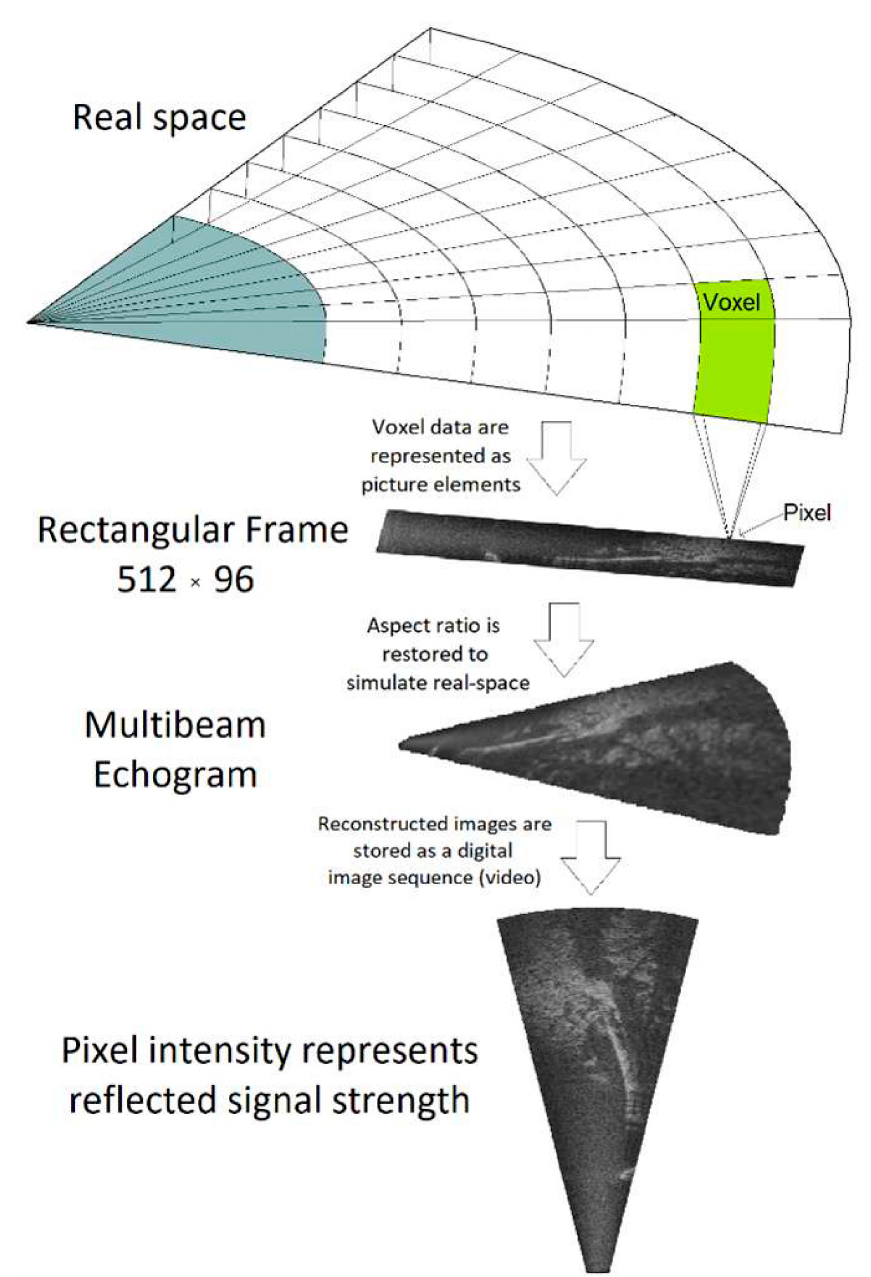
Figure 3. A conversion diagram of a real-world ensonified field-of-view to a digital image sequence representation.